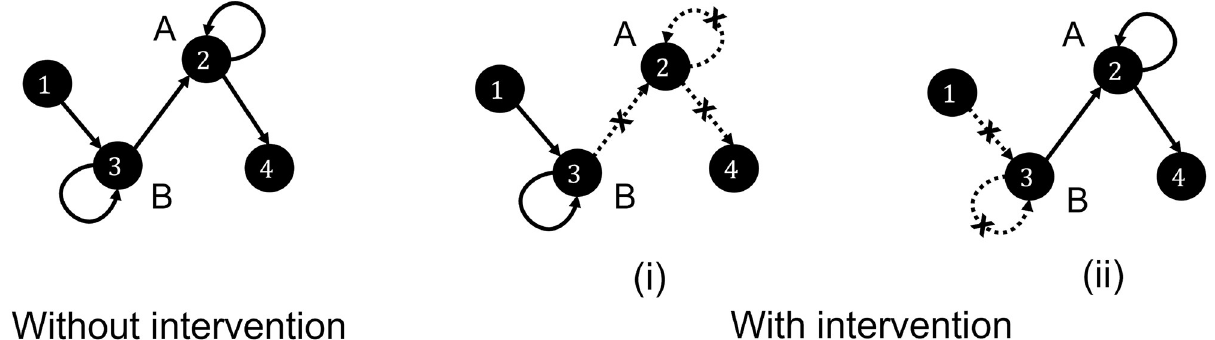
Fig 8. Impact of intervention. Rolled CFC-DPGM (left) for neurons 1–4 with dynamics as in Example 5.1, and consequence of intervention on neurons labelled A and B by (i) Ablation of A and (ii) External modulation of B.